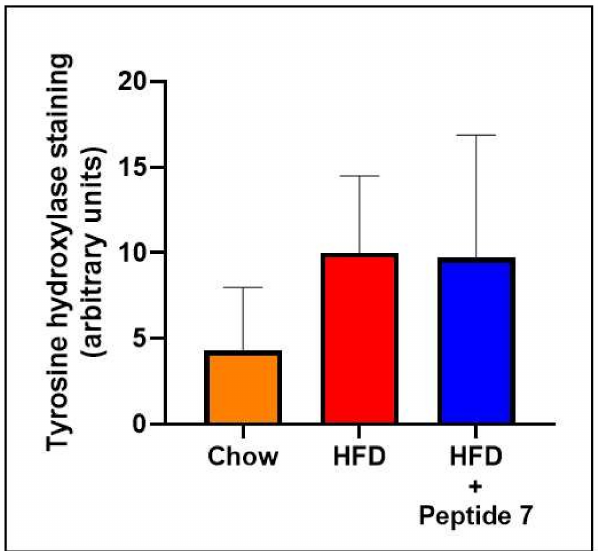
Figure 8. Peptide 7 did not decrease HFD-induced increases in tyrosine hydroxylase staining. Tyrosine hydroxylase expression in kidney. Tyrosine hydroxylase quantitation, n = 3–5 mice per group; Mean ±